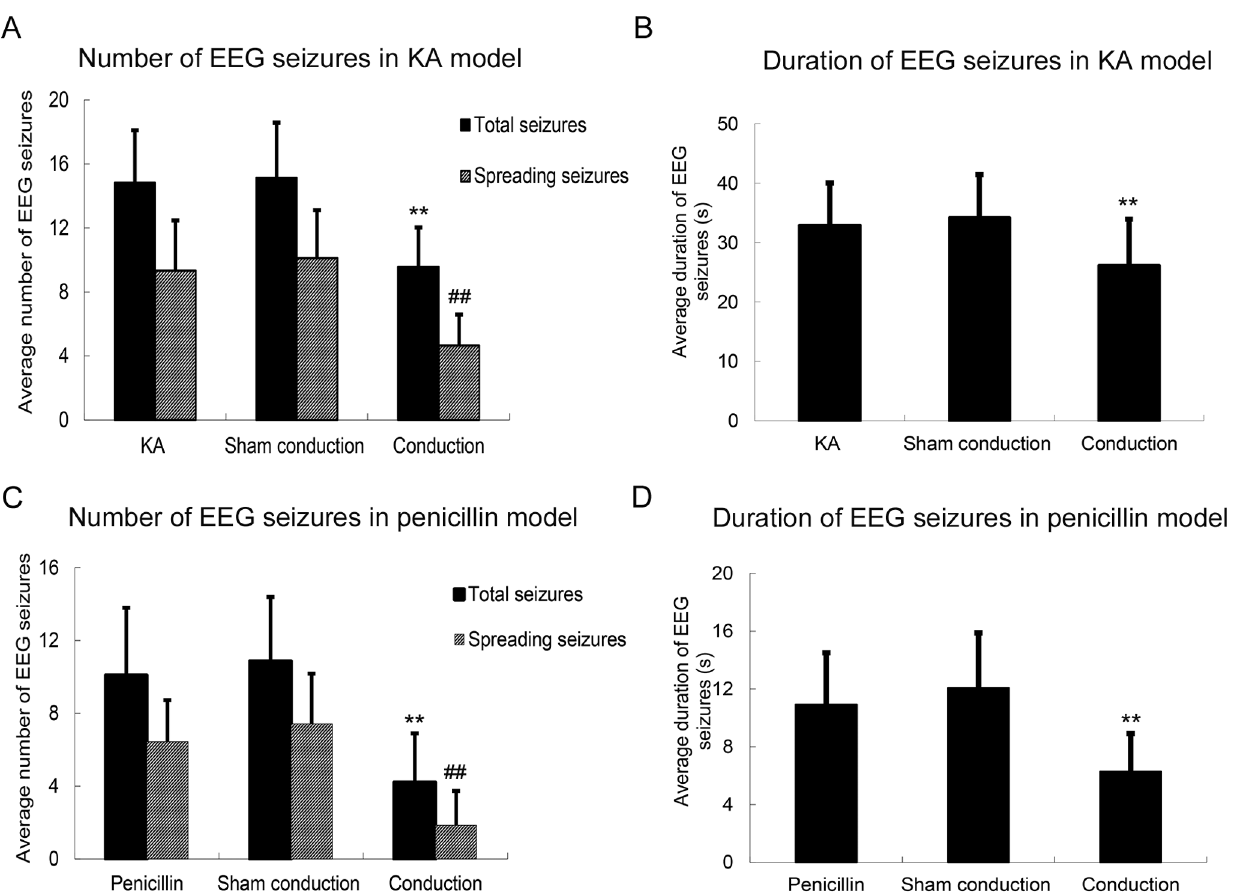
Figure 4. Effect of current shunt on seizures. (A)The average number of total EEG and spreading EEG seizures in the conduction group was significantly lower than that in the KA and sham conduction groups. A 36.7% reduction of total EEG seizures and a 54.1% reduction of spreading EEG seizures were observed in the conduction group compared with sham conduction group. (B) The average duration of EEG seizures in the conduction group (26.13 6 7.81 s) was significantly lower than that in the KA (32.88 6 7.16 s) and sham conduction groups (34.17 6 7.25 s). (C) The average number of total EEG and spreading EEG seizures in the conduction group was significantly lower than that in the penicillin and sham conduction groups. A 61% reduction of total EEG seizures and a 75% reduction of spreading EEG seizures were observed in the conduction group compared with the sham conduction group. (D) The average duration of the EEG seizures in the conduction group (6.29 6 2.64 s) was significantly lower than that in the penicillin (10.92 6 3.59 s) and sham conduction groups (12.07 6 3.81 s). The values are expressed as the means 6 standard deviation. ** p , 0.01, ## p , 0.01, conduction group versus the KA and sham conduction groups, respectively. One-way ANOVA followed by Bonferroni post hoc test.